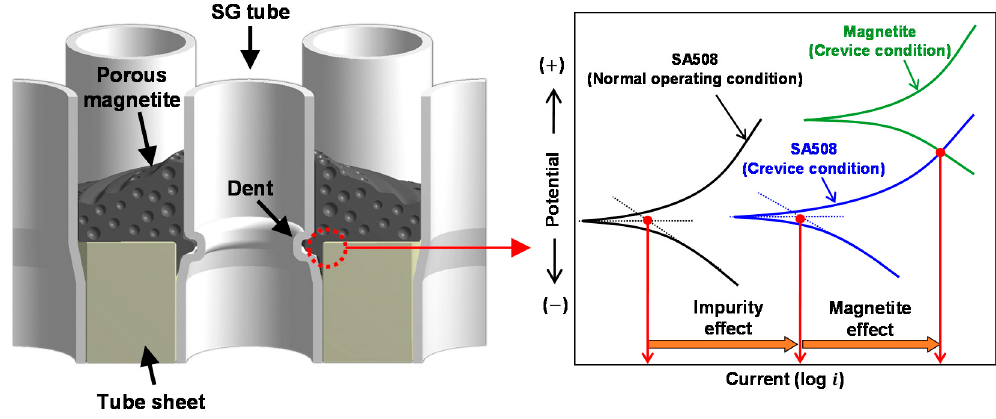
Figure 9. Schematic model for effect of magnetite on the corrosion of the tube sheet within the crevice covered with porous magnetite.